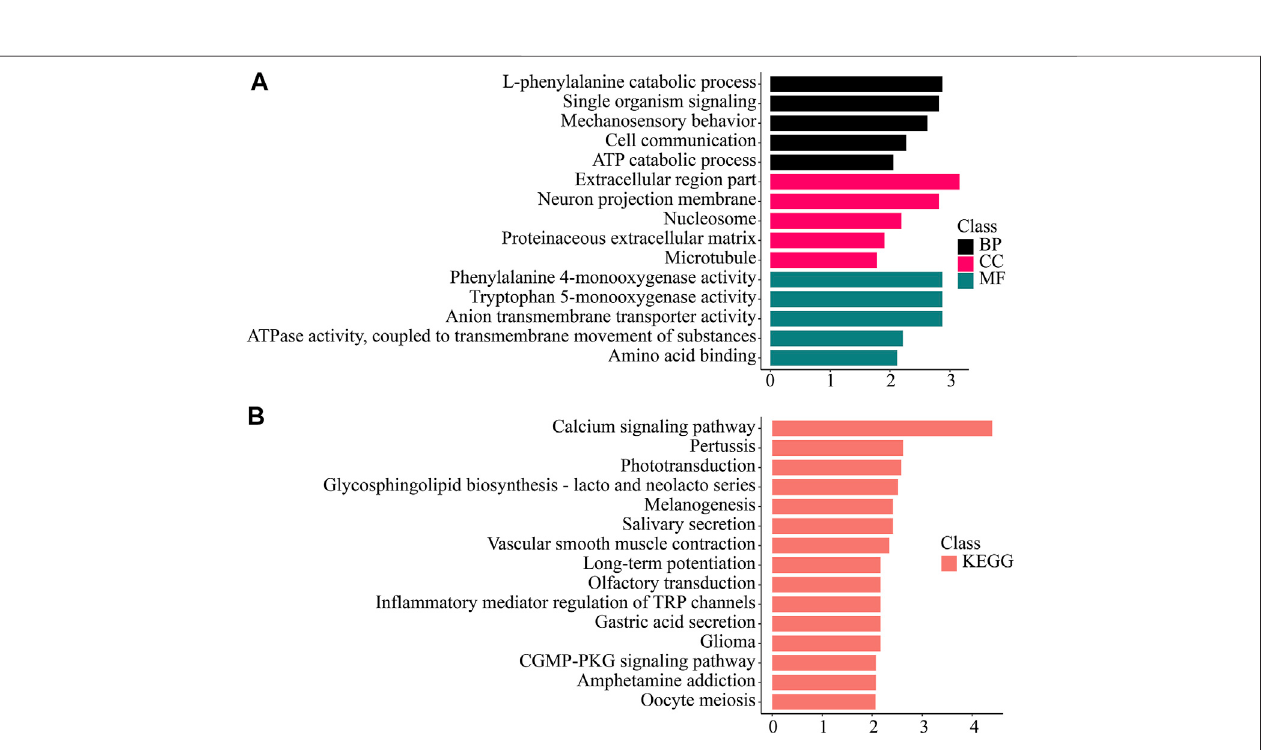
FIGURE 4 | Enrichment analysis of gill-speci fi c differentially expressed genes. (A) GO enrichment. BP: Biological process. CC: Cellular component. MF: Molecular function. (B) KEGG enrichment. KEGG: Kyoto Encyclopedia of Genes and Genomes; GO: Gene Ontology.